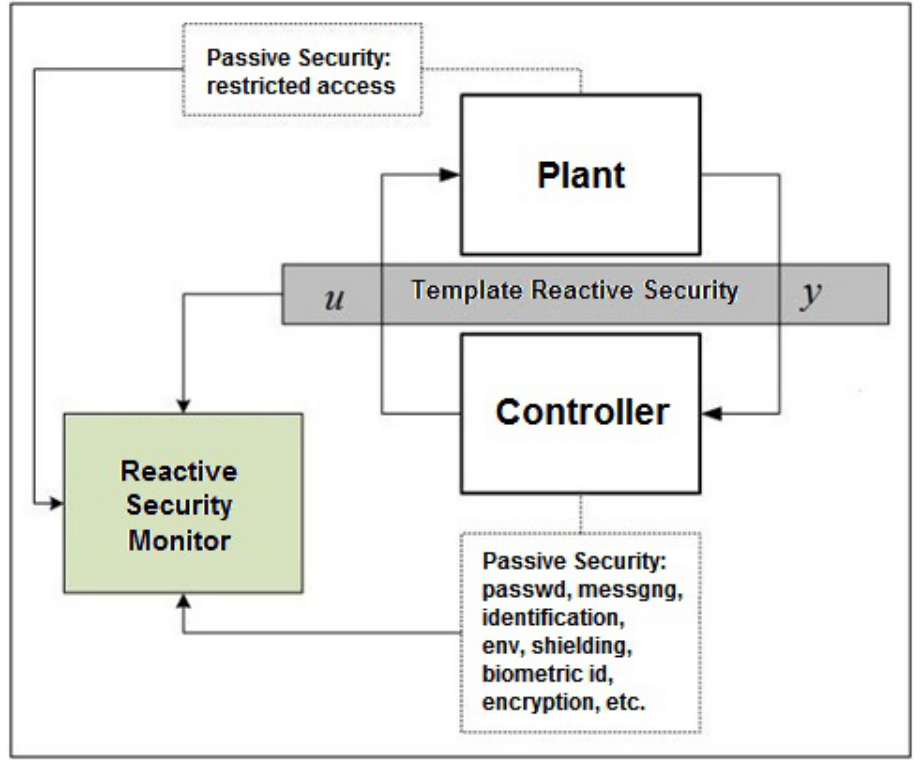
Figure 12. System view of the security monitoring in a cyberphysical